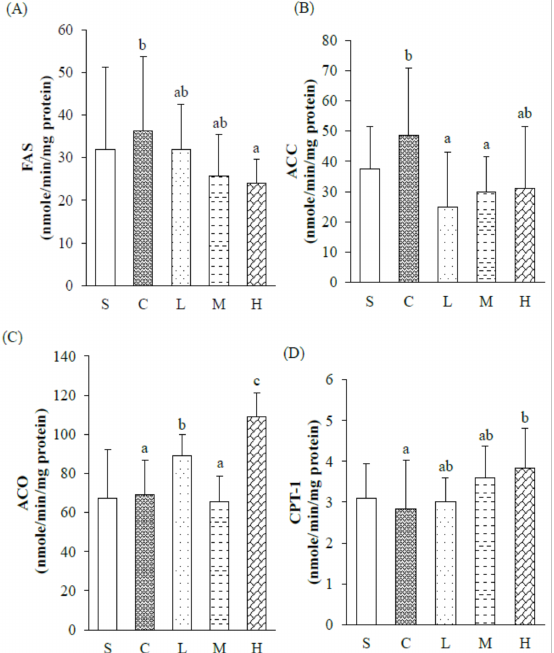
Figure 2. Hepatic lipid metabolic enzyme activities after 8 weeks of a dietary intervention. Hepatic ( A ) fatty acid synthase (FAS) activity, ( B ) acetyl CoA carboxylase (ACC) activity, ( C ) acetyl CoA oxidase (ACO) activity and ( D ) carnitine palmitoyltransferase (CPT)-1 activity. Results are presented as the mean ± standard deviation. abc p < 0.05 between different superscripts. S, sham-operated group; C, control group; L, low-dosage group; M, medium-dosage group; H, high-dosage group.